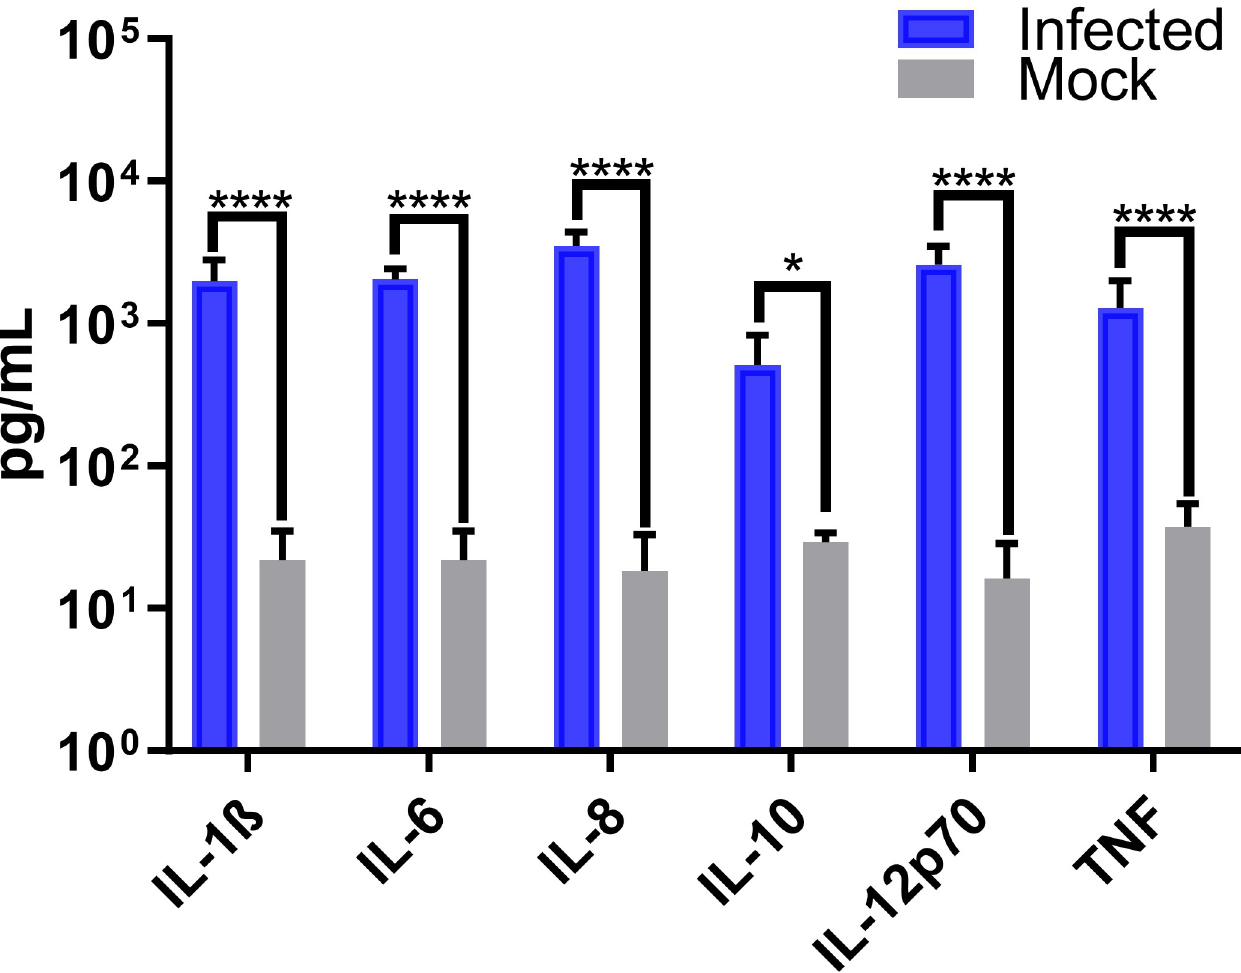
Fig 5. CHIKV infection induces pro-inflammatory cytokines in human macrophages. Secreted pro-inflammatory cytokine levels in CHIKV-infected PMA-differentiated U937 macrophages were quantified 24 hpi using cytometric bead arrays. Data show mean values of three independent experiments with a total of n = 9, MOI = 5. Statistical significance was determined using multiple t-test corrected using Holm-Sidak method. � P < 0.05; �� P < 0.01; ��� P < 0.001; ���� P < 0.0001; NS, not significant.